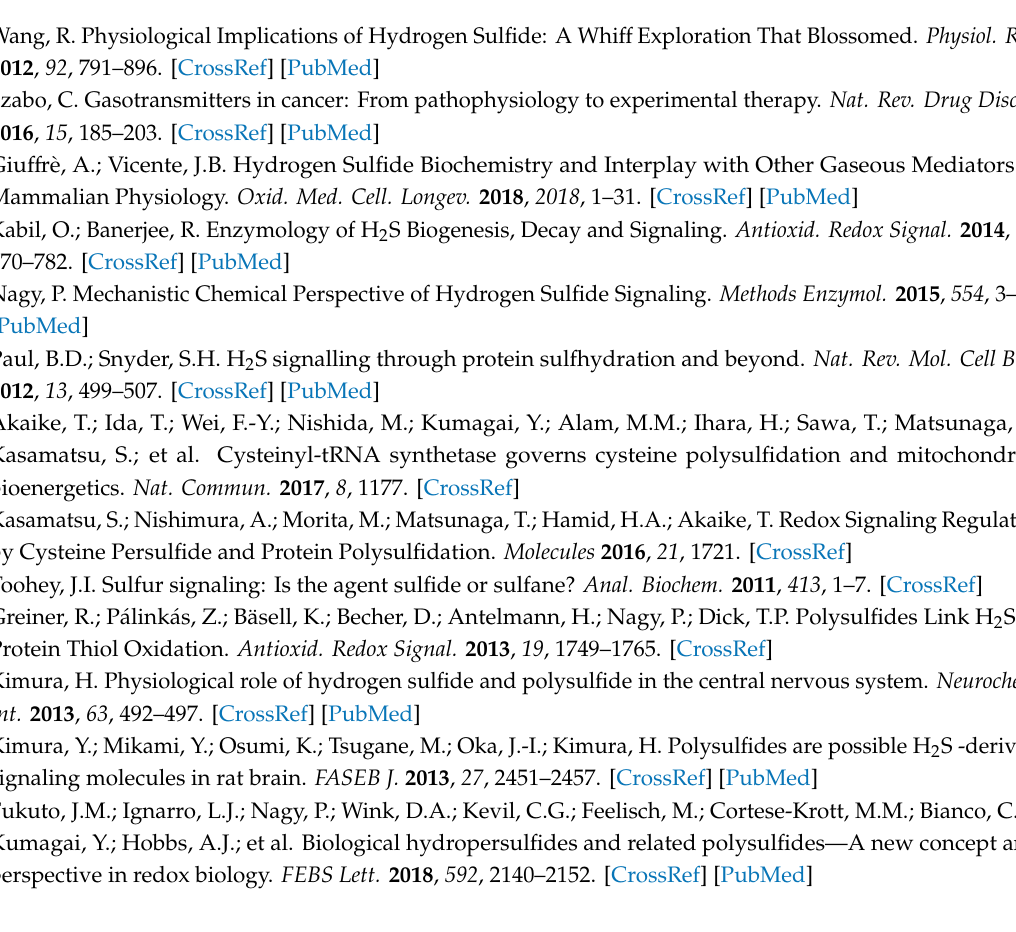
Figure S1. E ff ect of NAC on CBS and CSE expression, Figure S2. E ff ect of Cys on MST and SQR expression, Figure S3. E ff ect of NAC on mitochondrial content, Figure S4. E ffi ciency of mitochondria isolation, Figure S5. E ff ect of combined NAC and Cys on MST